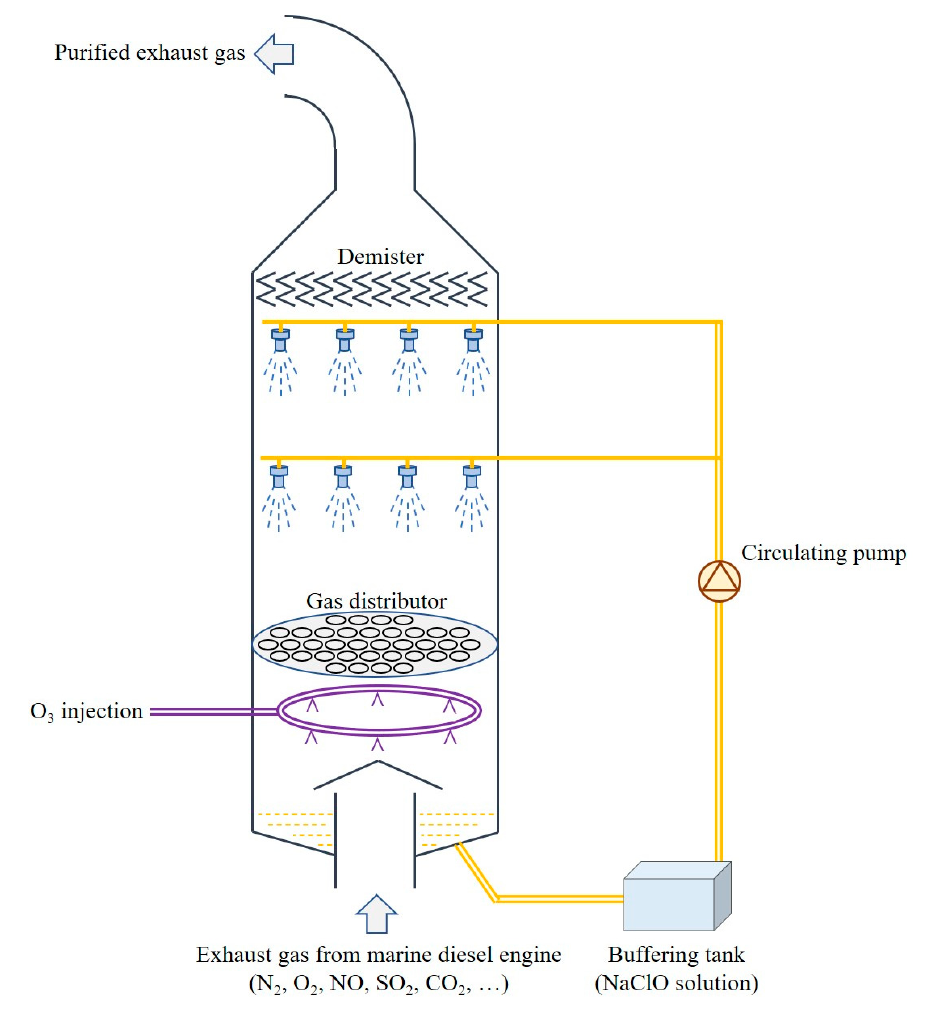
Figure 11. The proposed process diagram for simultaneous removal of NO and SO 2 from marine exhaust gas by ozone injection combined with in-situ wet scrubbing oxidant solution.